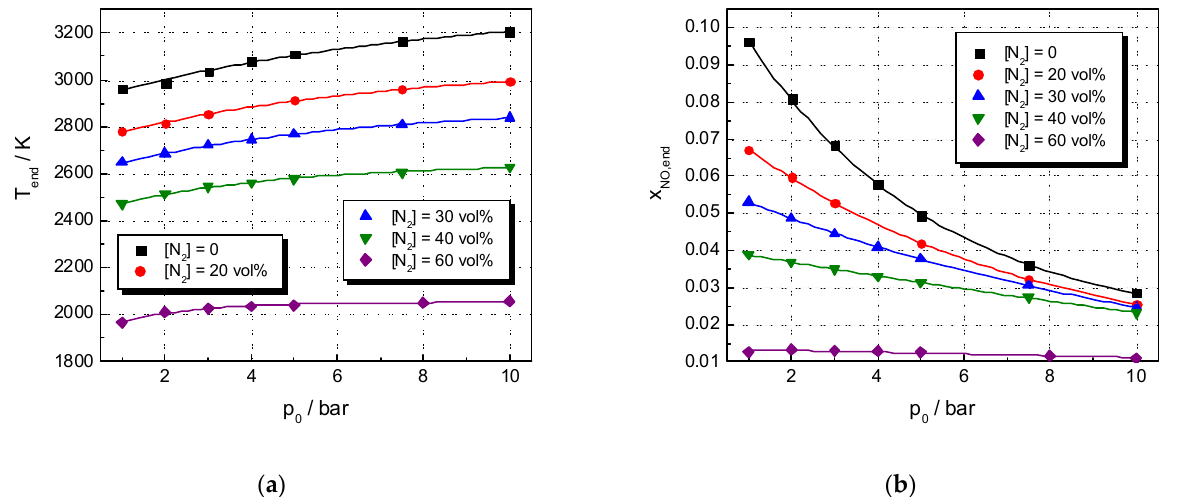
Figure 8. Influence of initial pressure on: ( a ) the end flame temperature (the increase in pressure caused an increase in the amount of flammable mixture in the volume unit, resulting in a temperature increase) and ( b ) end mass fraction of NO of stoichiometric H 2 –N 2 O mixtures that were diluted with various amounts of N 2 at an ambient initial temperature (the pressure increase resulted in a decrease in NO due to the flame temperature increase). For the same N 2 -diluted H 2 –N 2 O mixtures, the plots of the end mass fraction of NO and flame temperature against the initial temperature are shown in Figure 9a,b. At each constant initial pressure, both the end flame temperature and mass fraction of NO decreased as the initial temperature decreased, as shown in Figure